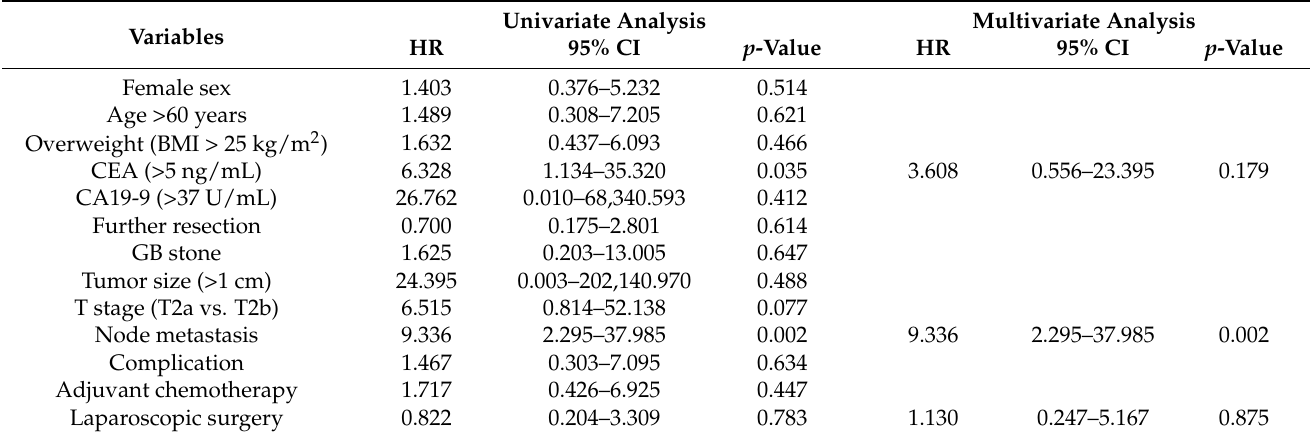
Table 5. Prognostic factors in T2 gallbladder cancer patients ( n =